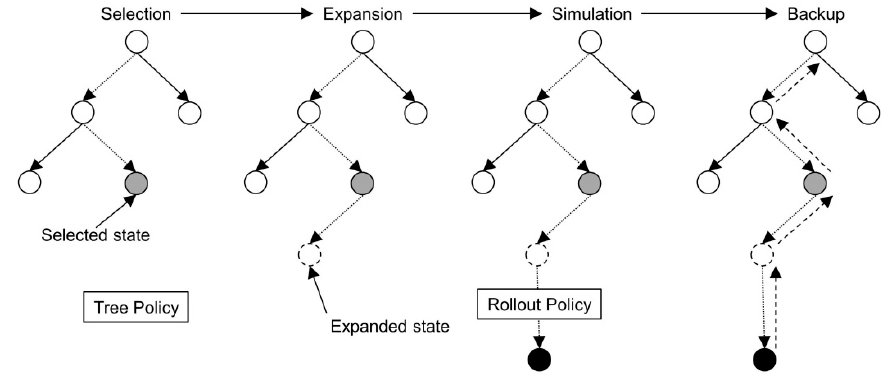
Figure 7. The four steps of the Monte Carlo tree search (MCTS) process: selection, expansion, simulation, and backup.